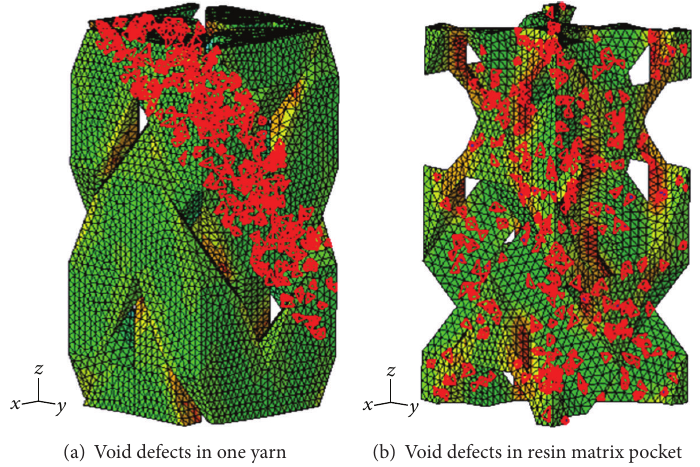
Figure 4: Random distribution of void defects in